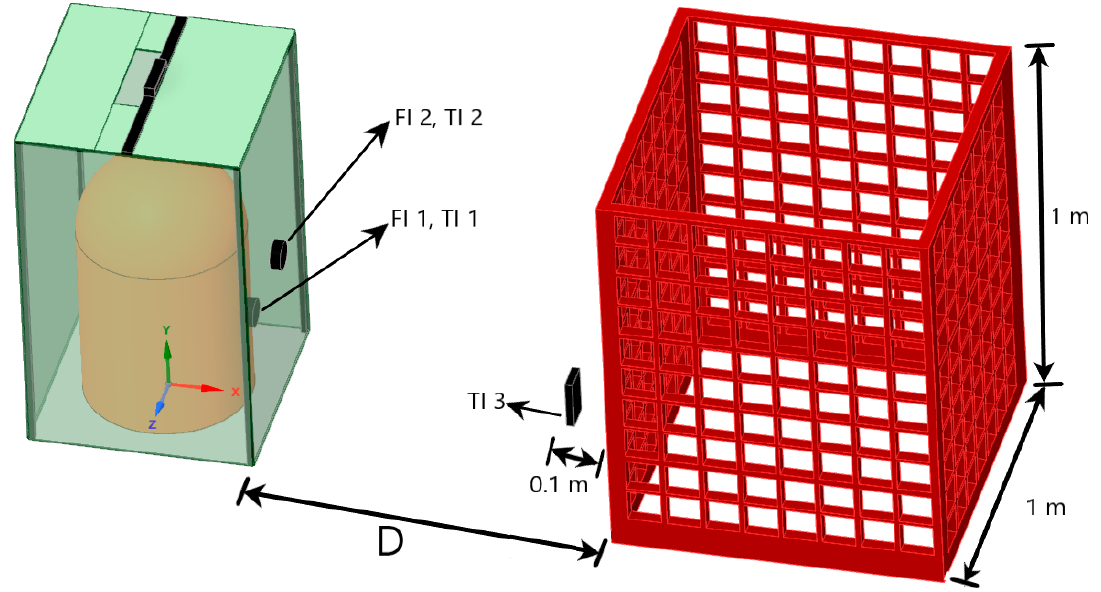
Figure 1. Schematic drawing of laboratory test: protective device at the four distances “D” from the fuel basket, and the instrument’s position on the cylinder’s surface (FI 1, TI 1), fabric’s surface (FI 2, TI 2), and thermocouple 3.